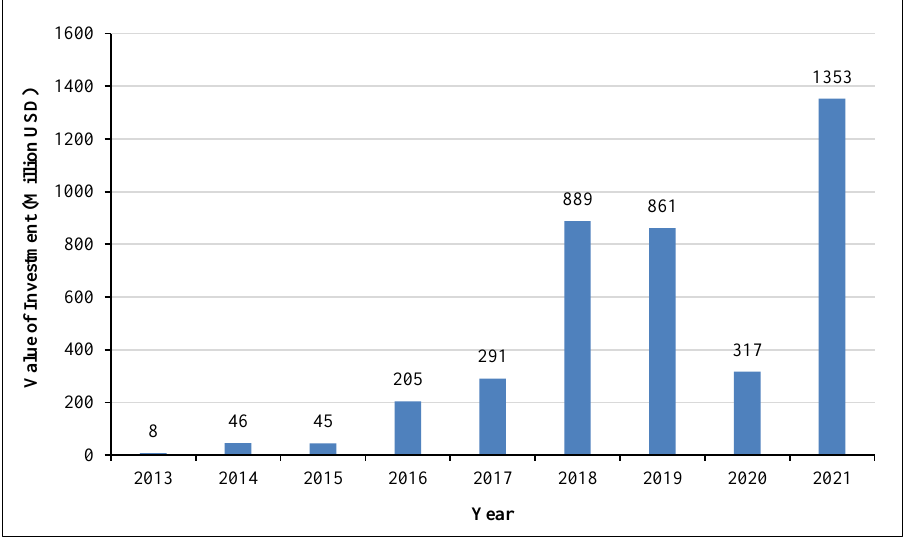
Figure 2. Investment in Vietnamese startups, 2013-2021 (Nextrans 2022)